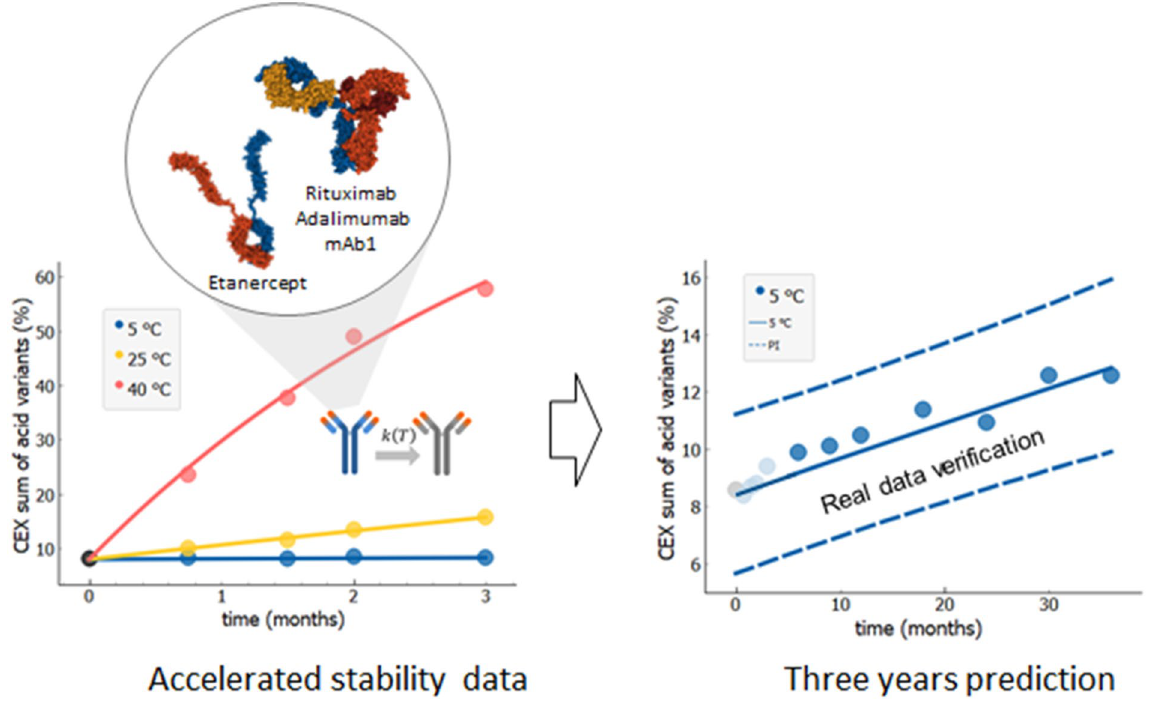
Figure 2. Long-term (36 months) stability prediction based on accelerated stability data (3 months) and kinetic modelling which included Arrhenius temperature dependence of kinetic rates. Accelerated stability data (left, data points) are used to develop the kinetic model (left, full lines) to predict long-term stability at intendent storage conditions (right). The 95% probability prediction interval designated by dashed blue lines is verified by long-term experimental data not used in model fitting (right, dark blue data points). Stability prediction was evaluated for three mAbs (rituximab, adalimumab and mAb1) and for one fusion protein etanercept. Shown data points are values of sum of acid variants obtained by CEX, one of the stability indicating quality attribute, measured for one batch of rituximab. Each point represents single measurement ( N = 1). Measurement accuracy SD = 1.5% was estimated by several measurements of control samples over multiple analytical runs. Protein structures created using 1HZH 43 , 1H3W 44 and 3ALQ 45 structures from RCSB PDB (rcsb.org) 46 using Mol* 47 and Snagit (TechSmith, Okemos, MI,